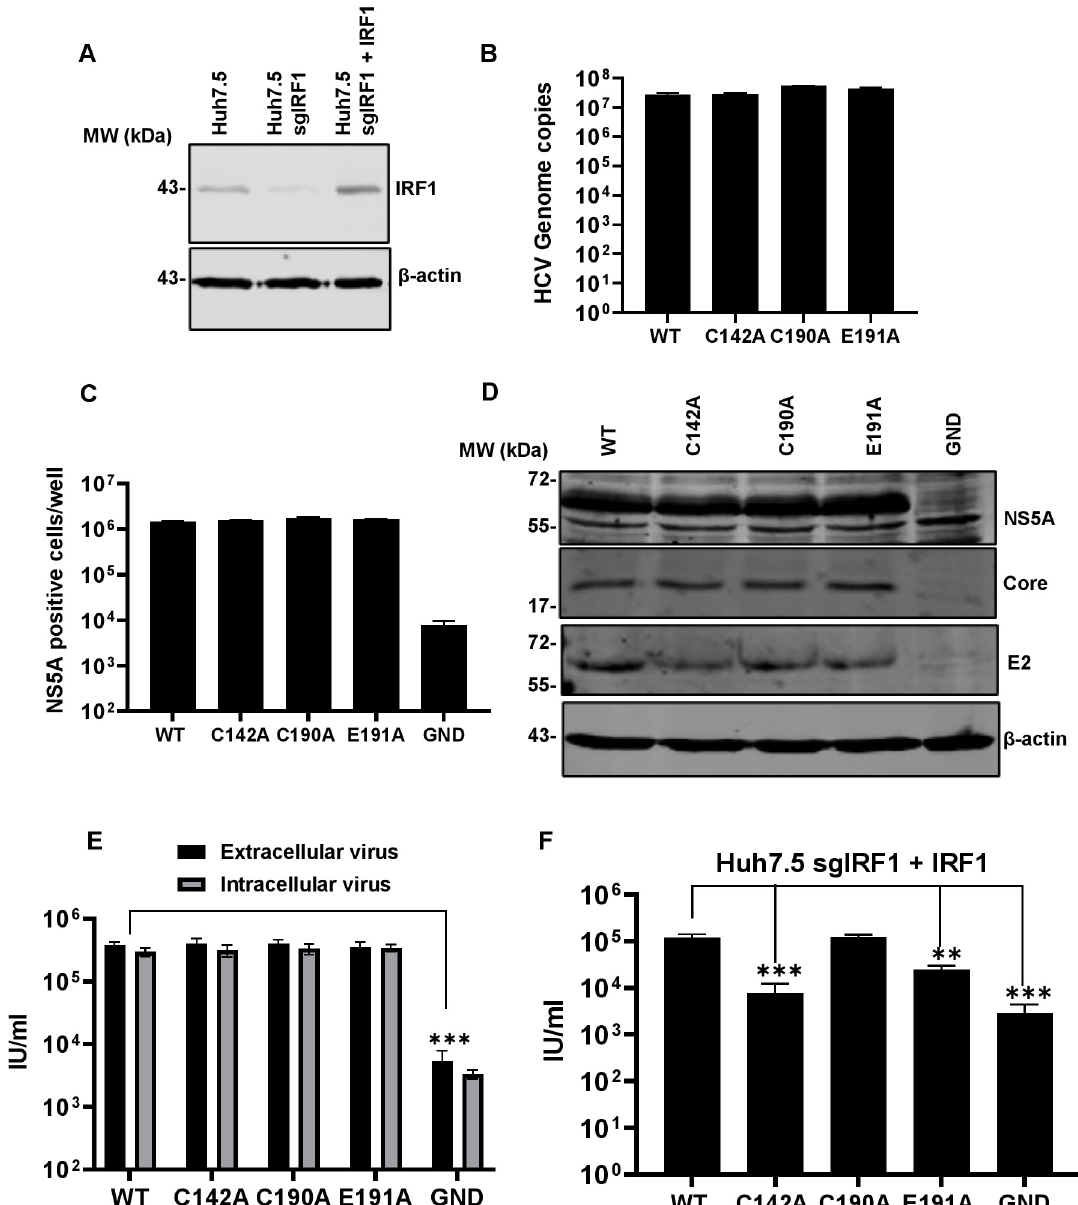
Fig 14. Virus assembly in IRF1-silenced Huh7.5 cells. (A) IRF1 expression was detected in control Huh7.5 cells, silenced (Huh7.5 sgIRF1), and cells subsequently transfected with an IRF1 expression vector (Huh7.5 sgIRF1 + IRF1) by western blot. (B-G) Huh7.5 cells were electroporated with mJFH-1 WT and DI mutant C142A, C190A and E191A RNAs, together with an NS5B GND mutant as negative control. Virus genome replication was analysed detected directly by quantification of genome copies in cell lysates using qRT-PCR ( B ), and indirectly by enumerating NS5A positive cells at 72 hpe using the IncuCyte S3 ( C ). (D) Cell lysates were collected at 72 hpe and then analysed by western blot with the indicated antibodies. (E) . Extra- and intracellular virus harvested at 72 hpe were titrated onto Huh7.5 cells and quantified using the IncuCyte S3. (F) Extracellular virus harvested at 72 hpe was titrated in Huh7.5 cells and quantified using the IncuCyte S3. N = 3, significant differences from WT denoted by �� (P < 0.01) and ��� (P < 0.001). and E191A, compared to WT and C190A, consistent with the inability of the assembly defective mutants to block PKR/IRF1 signalling. These data confirmed that the ability of PKR to inhibit the assembly of HCV is mediated by its activation of the downstream effector IRF1.